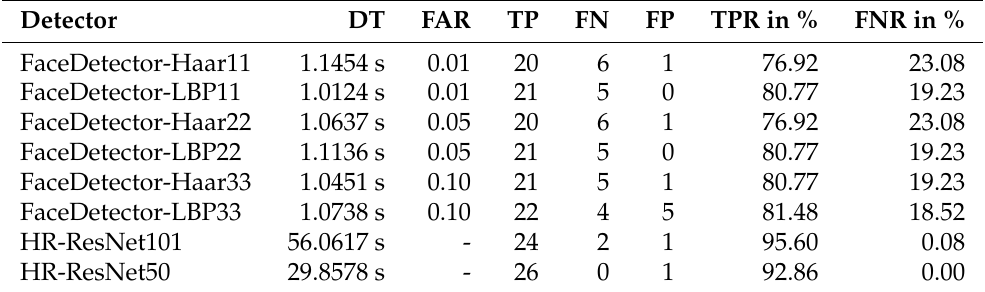
Table 2. Performance of custom trained Haar-like and LBP features for 0.01, 0.05, and 0.1 false alarm rate (FAR) values and eight layers of stages.